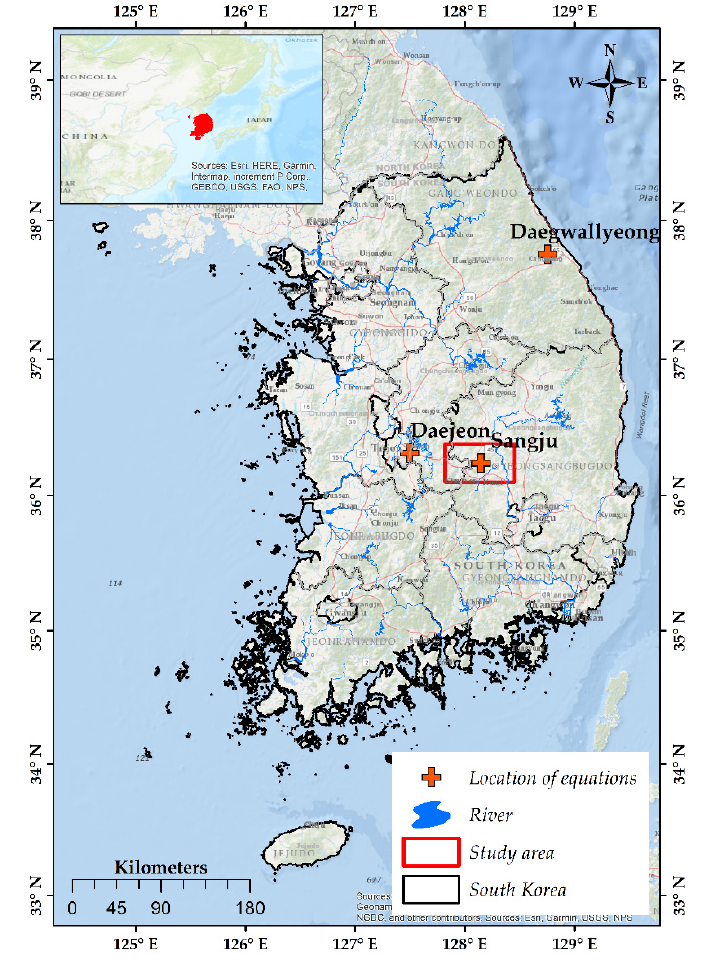
Figure 1. Location of Sangju City in Korea.